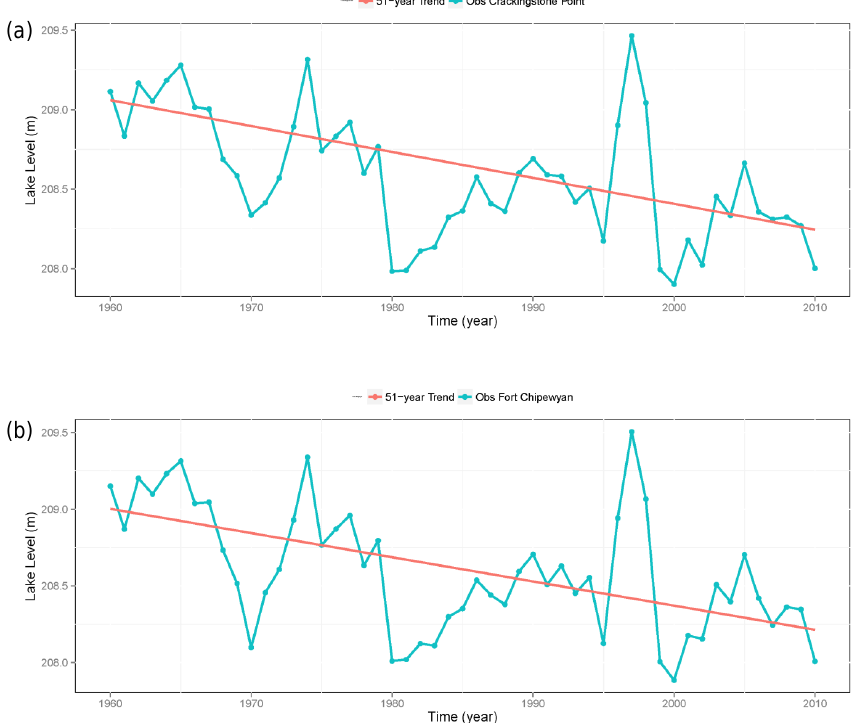
Figure 1. Time series and linear trends of naturalized, mean annual level of Lake Athabasca observed (Obs) (a) near Crackingstone Point and (b) at Fort Chipewyan,